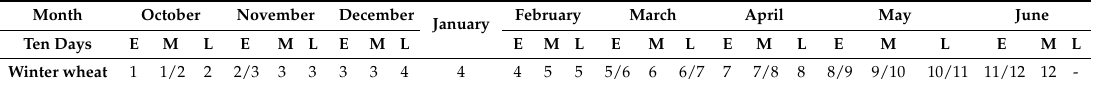
Winter wheat: 1, Sowing 2, Seedling. 3, Tillering. 4, Overwintering. 5, Greening up. 6, Jointing. 7, Booting. 8, Heading. 9, Flowering. 10, Milk ripening. 11, Maturing. 12, Harvesting. E, M, and L represent the first, middle, and last 10 days of a month, respectively.